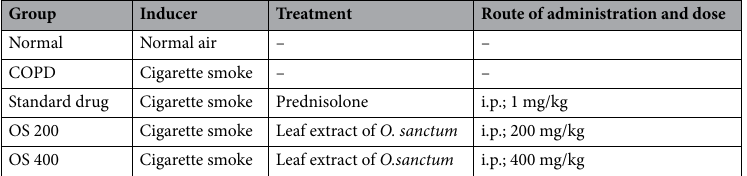
Table 2. Grouping of